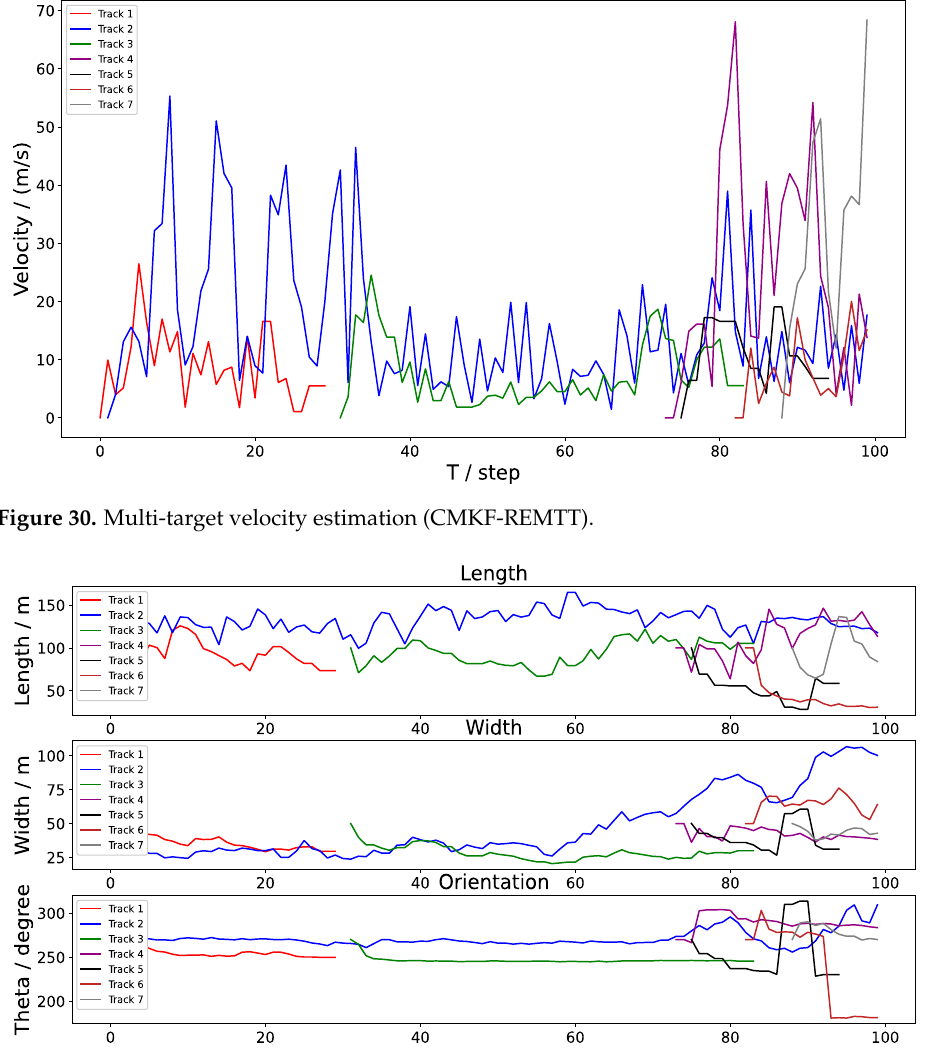
Table 3. Comprehensive comparison of three algorithms.